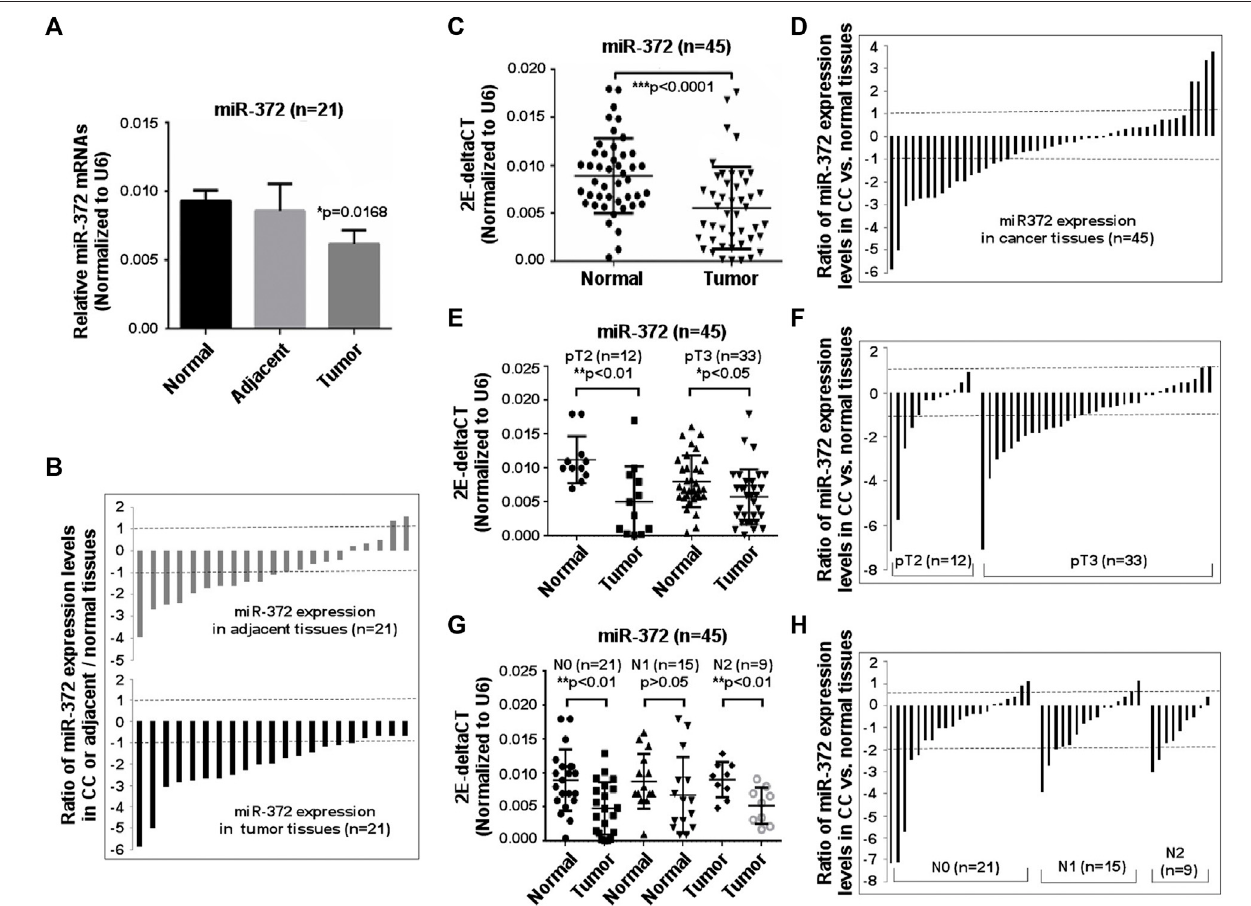
FIGURE2| DownregulationofmiR-372-3pwasobservedincoloncancertissues. (A) miR-372-3pexpressionlevelsincoloncancer.Tissuesamplesfrom21colon cancer patients and their matched adjacent and normal tissues were used to assess the miR-372-3p expression (normalized to U6). Data are presented using mean ±standarddeviationvalues.* p < 0.05vs.normalgroup. (B) ExpressionpatternsofmiR-372-3pincoloncancer.Eachbarpresentsthelog2valueoftheratioofmiR-372- 3pexpressionlevelsbetweencoloncancerandmatchednormaltissuesoradjacentandnormaltissuesfromthesamepatients( n =21).Abarvalue > 1representsa > 2-fold increase, whereas a bar value < 1, represents a > 2-fold decrease. Each bar represents the means of three independent replications. (C) 2E-deltaCT (normalized to U6) values ofmiR-372-3p in colon cancer and normal tissues. *** p < 0.001 vs. normal tissues. (D) Ratios of miR-372-3p expression levels between colon cancer and matched normal tissues from the same patients (n = 45). (E) 2E-deltaCT analysis of pathologic stage T2 and T3 tissue samples. Values are displayed per 2E-deltaCT (normalized to U6) in colon cancer or matched normal tissues. * p < 0.05, ** p < 0.001 vs. normal tissues. (F) Patterns of miR-372-3p mRNA expression at pathological stageT2andT3. (G) Resultsof2E-deltaCTanalysisperformedaccordingtothelymphnodestatus.* p < 0.05,** p < 0.001vs.thenormalgroup. (H) PatternsofmiR-372- 3pmRNAexpressionindifferentlymphnodestatus.N0,nonearbylymphnodemetastasis;N1,onetotwonearbylymphnodemetastasis;N2,threetosixnearbylymph nodemetastasis.AllqPCRswereperformedinthreeindependentexperimentswiththreereplicatespergroup.Statisticaldifferencesbetweentwogroupswereanalyzed using the Mann Whitney test. CC, colon